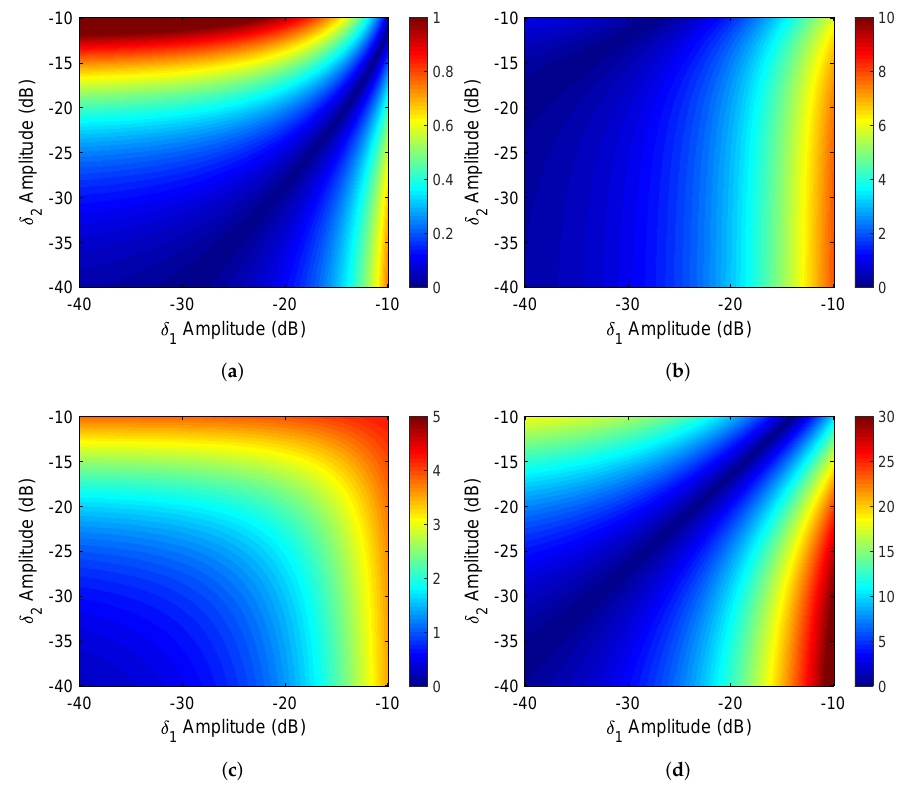
Figure 2. The distortion parameter estimation error of the ICT scheme under different crosstalk levels. ( a ) amplitude imbalance (dB). ( b ) phase imbalance ( ◦ ). ( c ) amplitude of transmission crosstalk (dB). ( d ) phase of transmission crosstalk ( ◦